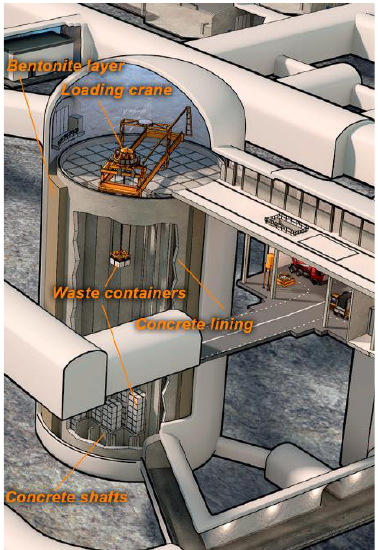
Figure 9. SFR repository SILO bunker cross-sectional view [45].